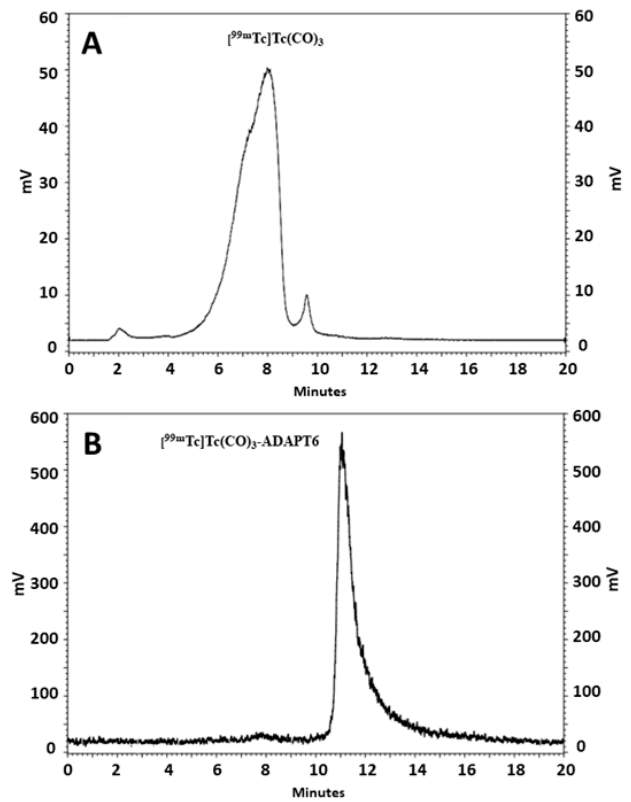
Figure 1. Reversed-phase high performance liquid chromatography (RP-HPLC) analysis of [ 99m Tc]Tc(CO) 3 ( A ) and ADAPT6 labeled with [ 99m Tc]Tc(CO) 3 ( B ).